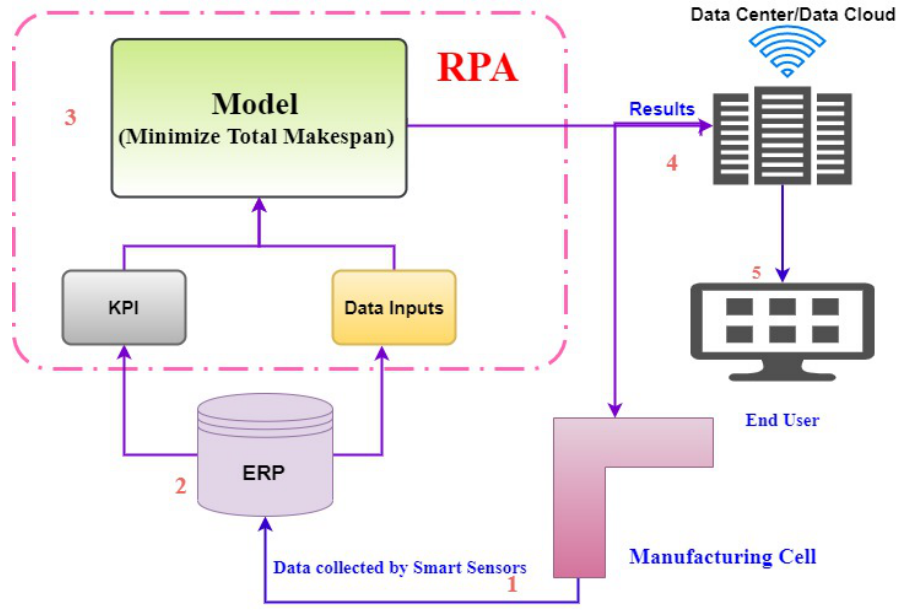
Figure 1. Problem-description